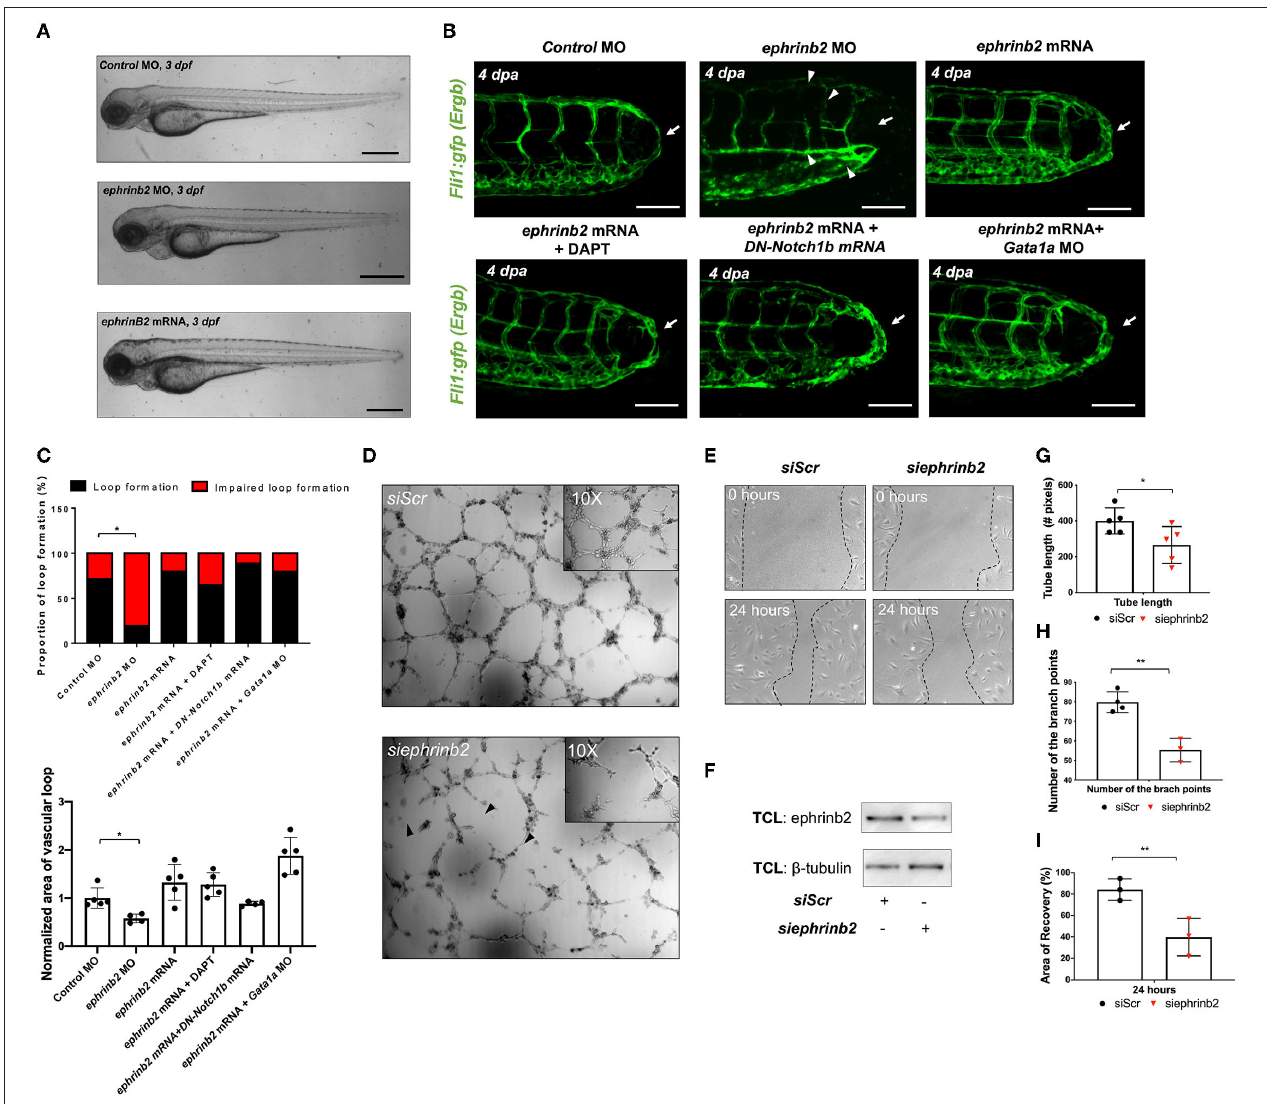
FIGURE 5 | Ephrinb2 regulates vascular loop formation. (A) Gross morphology following global ephrinb2 modulation. Both ephrinb2 MO and mRNA injections did not affect gross zebrafish morphology (white arrowheads). Scale bar: 100 µ m. (B) Compared to the MO-injected controls, ephrinb2 MO (0.5–1mM)-injected embryos had impaired loop formation (white arrow) altered the DA and SV morphology, immature CVP and DLAV at 4 dpa (white arrowheads). Transient overexpression of ephrinb2 mRNA restored DAPT, DN- Notch1b mRNA (10–20 pg/nl) and Gata1a MO-impaired loop formation (white arrows). Scale bar: 20 µ m. (C) Quantification of the proportion of embryos exhibiting loop formation and normalized area of vascular loop ( * p < 0.05 vs. control MO, n = 20 per group). (D,E) Representative images of Matrigel and human aortic endothelial cell (HAEC) migration assays following siScr or siephrinb2 transfection. (F) The density quantification of ephrinb2 expression following siephrinb2 transfection. TCL: total cell lysates (G,H) siephrinb2 transfection reduced both tube length and the number of branch points as compared to siScr -transfected HAEC ( * p < 0.05, ** p < 0.005 vs. siScr , n = 5 for tube length, n = 4 for branch point). (I) siephrinb2 transfection reduced the attenuated area of recovery (A.O.R) by ∼ 45% at 24h post scratch ( ** p < 0.005 vs. siScr , n = 3 per